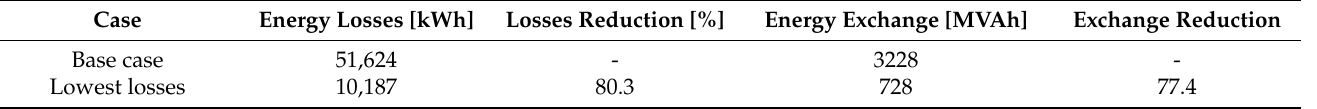
Table 4. Annual energy losses and